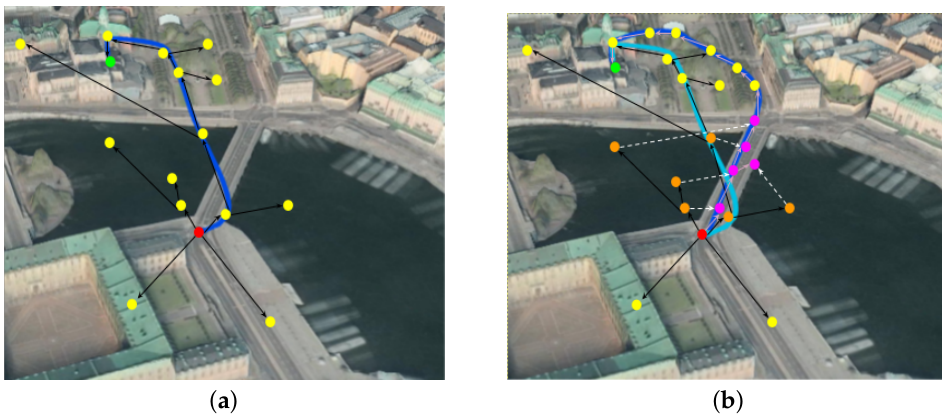
Figure 11. Path Finding With Constraints. The initial, goal and valid samples are in red, green and yellow, respectively. The generated collision-free path is in dark blue. ( a ) Constraint: Elevation of regions; ( b ) Constraint: Water Areas. Invalid samples are in orange and their alternatives are in pink.